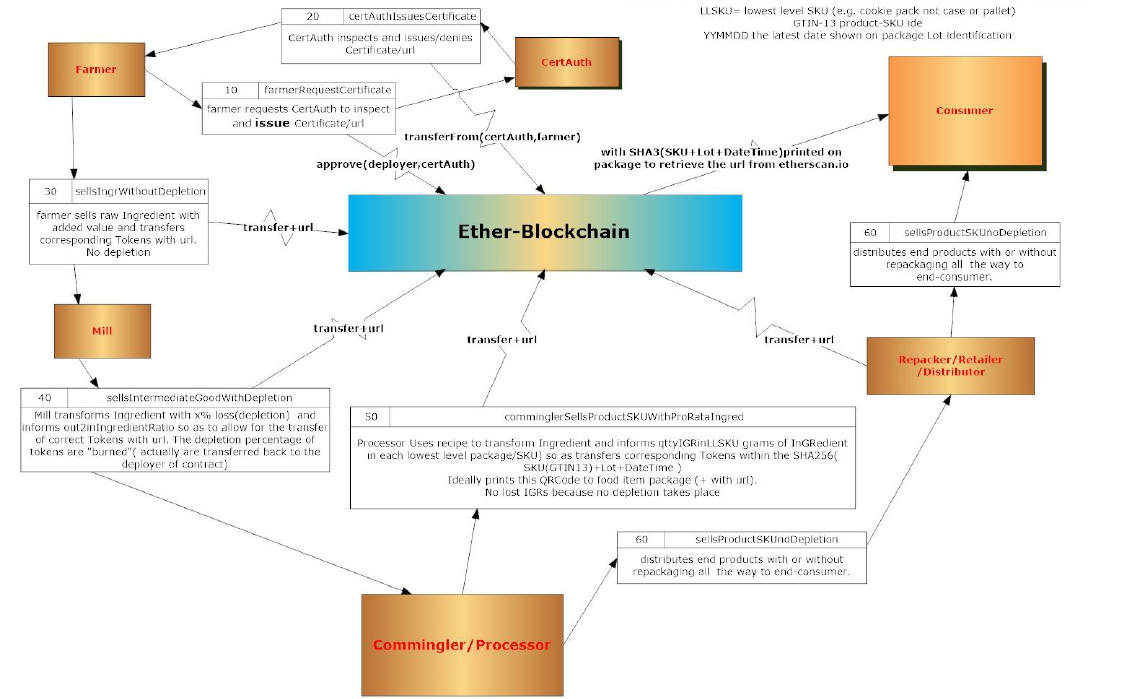
Figure 8. IGR token data flow